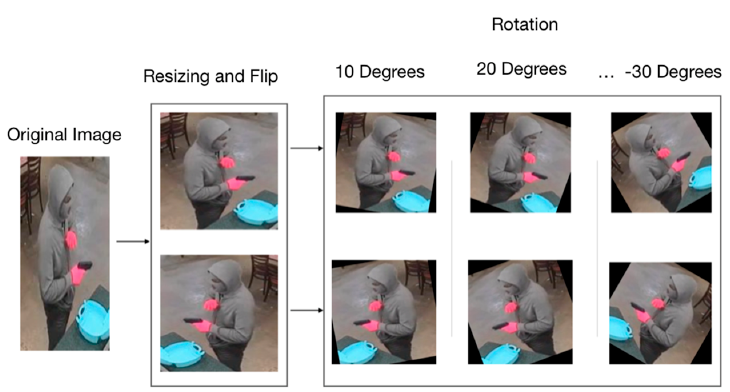
Figure 5. Database augmentation.